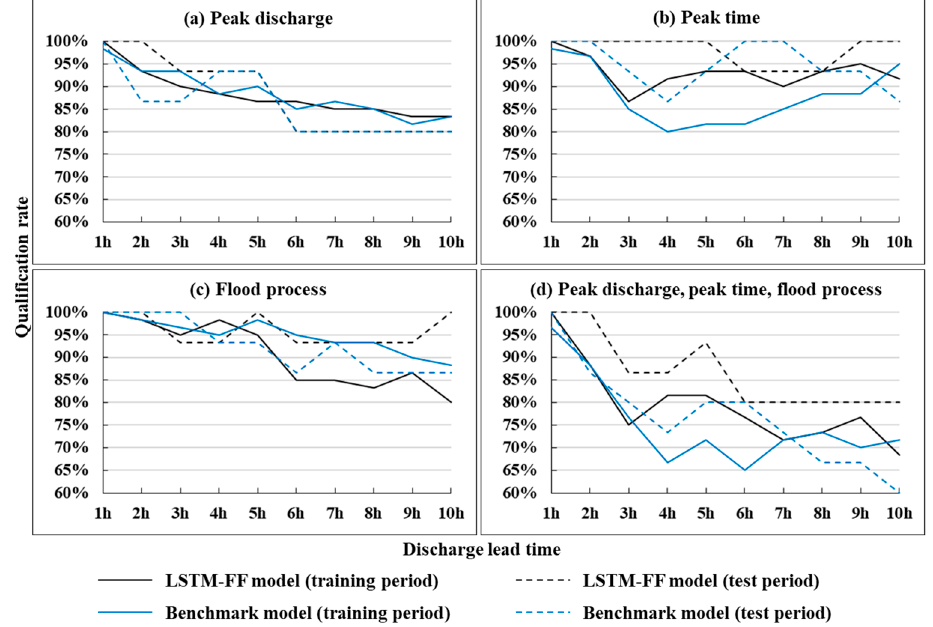
Figure 5. Qualification rate of the training period and test period.